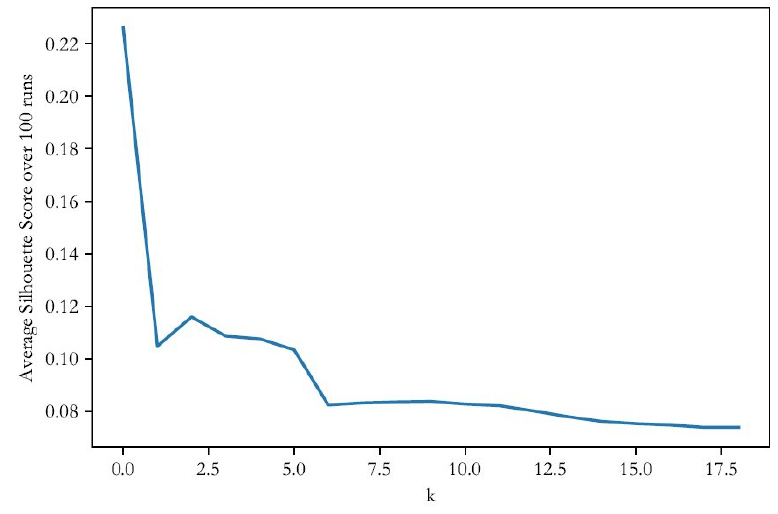
Figure 4. Average silhouette values for different values of k , urban block groups.